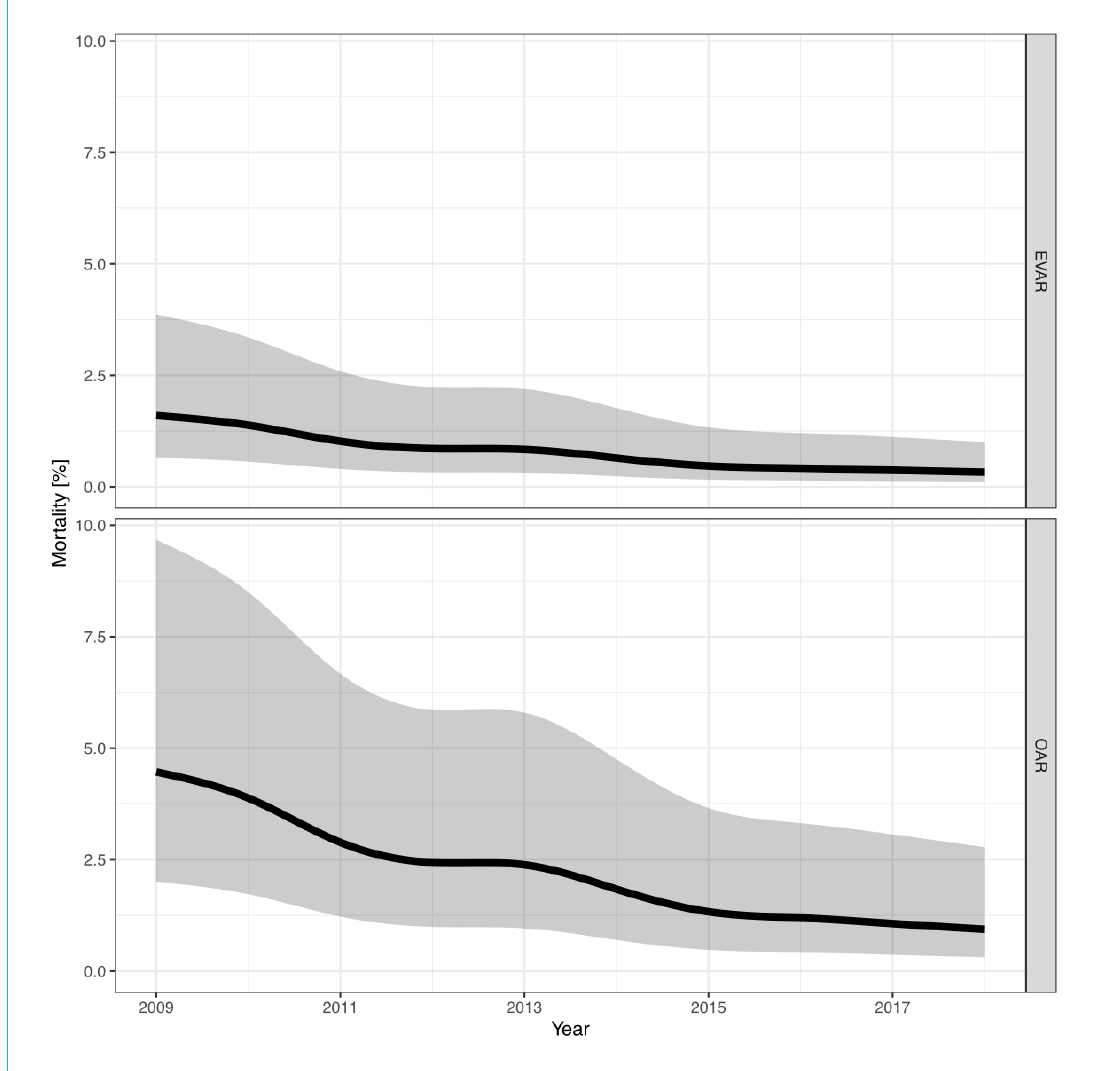
Figure S2: Mortality of patients treated for nonruptured abdominal aortic aneurysms (nrAAA) stratified by treatment. Smoothed adjusted in- hospital mortality rates with 95% confidence interval of patients treated for nrAAA stratified by treatment. Adjustments were made for age,